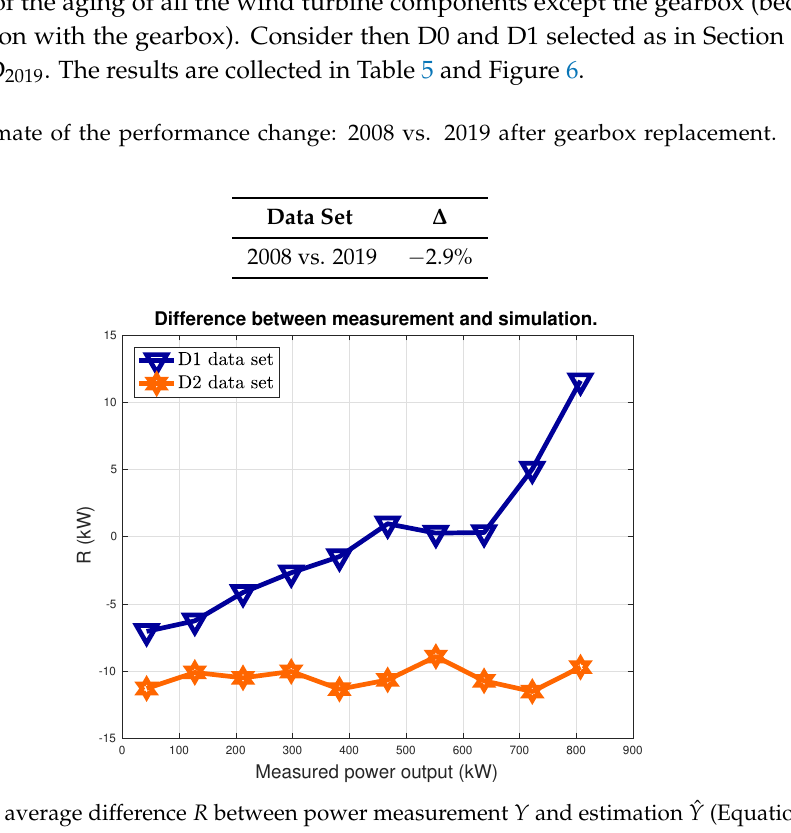
Figure 6. The average difference R between power measurement Y and estimation ˆ Y (Equation (14)). Data sets: 2008 and